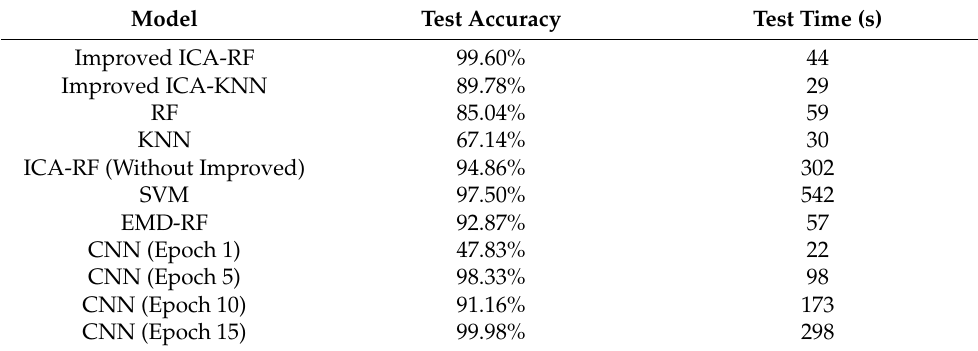
Figure 23. Result of CNN. Table 5. Compare of